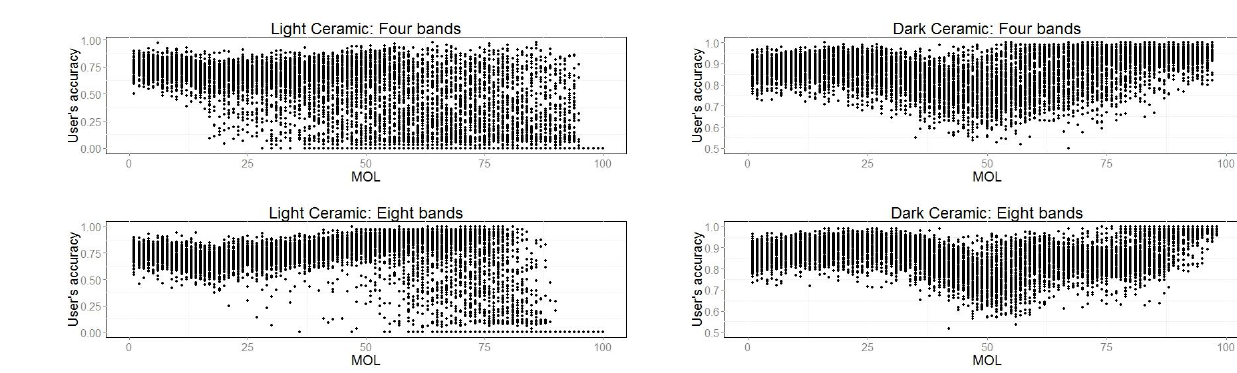
Figure 5. L IGHT C ERAMIC user’s accuracy × MOL for each iteration.